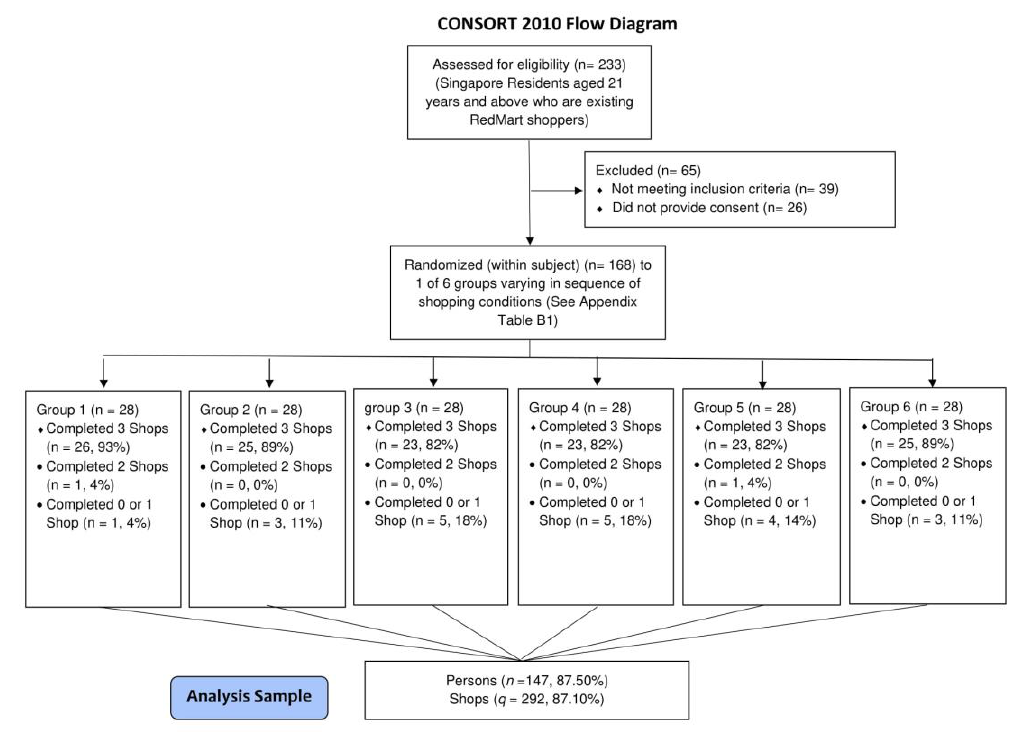
Figure 3. CONSORT flow diagram for participant recruitment and randomization.